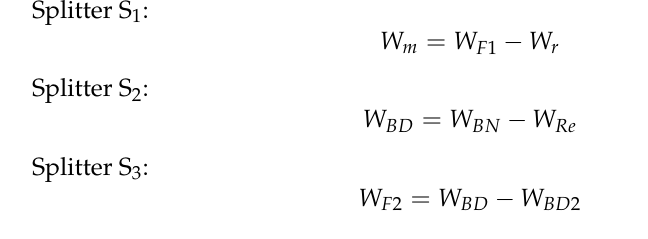
Figure 4. Option 4—the last-stage flash water of the BR-MSF system as the feed water of the Figure 4. Option 4 — the last-stage flash water of the BR-MSF system as the feed water of the SWRO SWRO system.